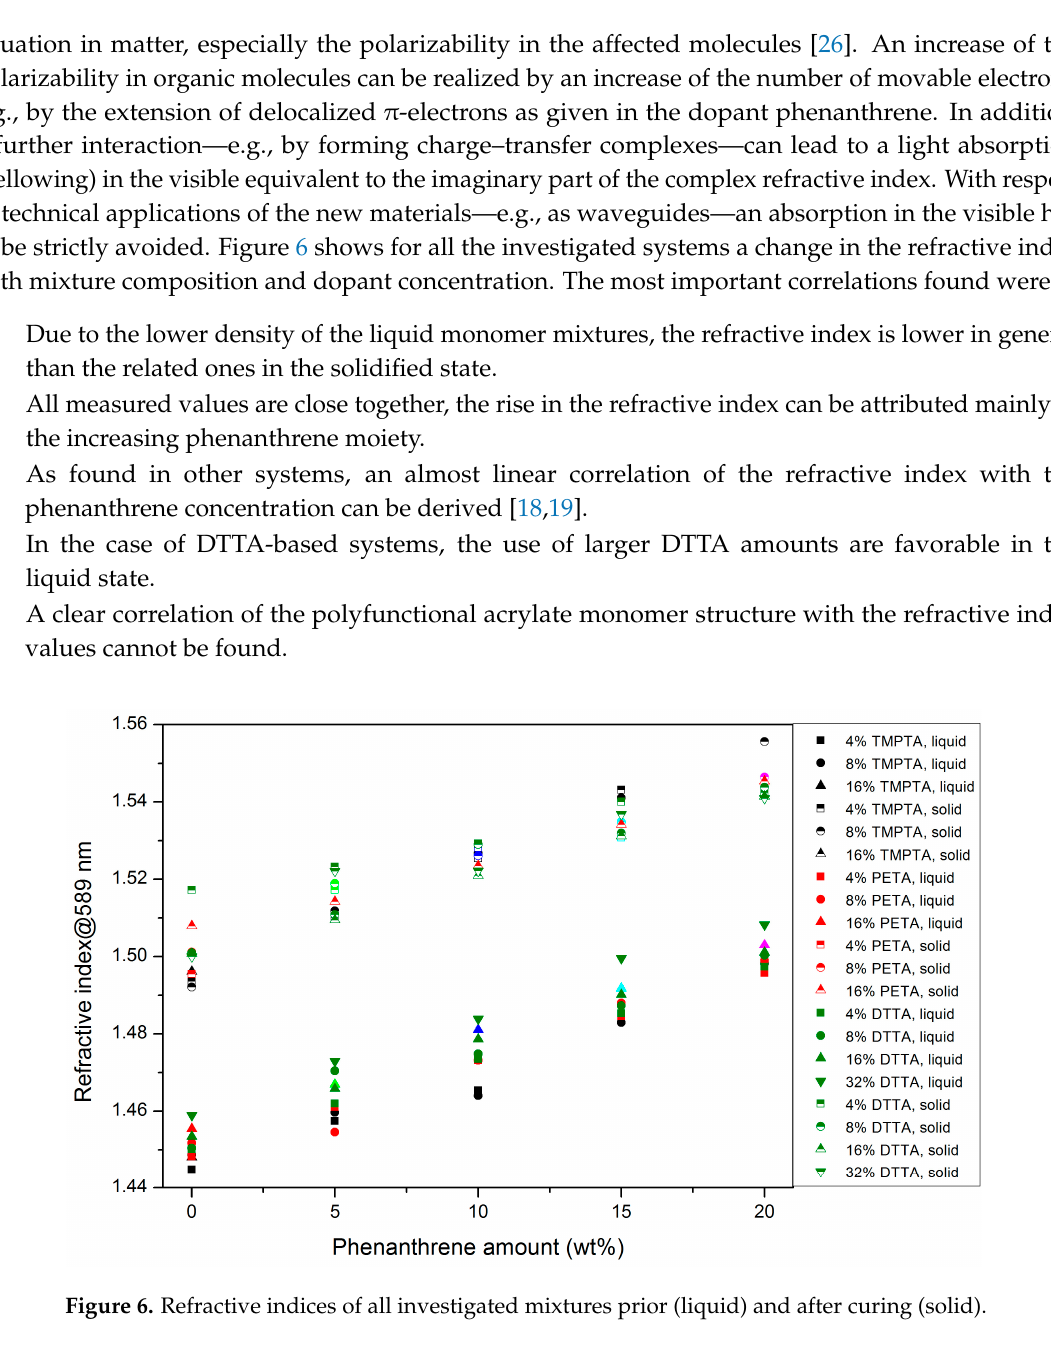
( b ) Figure 7. Optical transmittance of DTTA-containing mixtures: ( a ) Influence of DTTA content without and with 10% phenanthrene; ( b ) Influence of phenanthrene content at constant DTTA amount. Mixtures consisting of TMPTA or PETA in combination with phenanthrene showed comparable transmittance behaviour due their similar chemical structure without functional groups absorbing in the visible range. The main result of this subsection can be summarized as follows: large refractive indices, gener- ated with huge dopant concentrations, have the drawback of the reduced optical transmittance of the used doped copolymer. The amount of polyfunctional acrylate monomer has a certain influence on